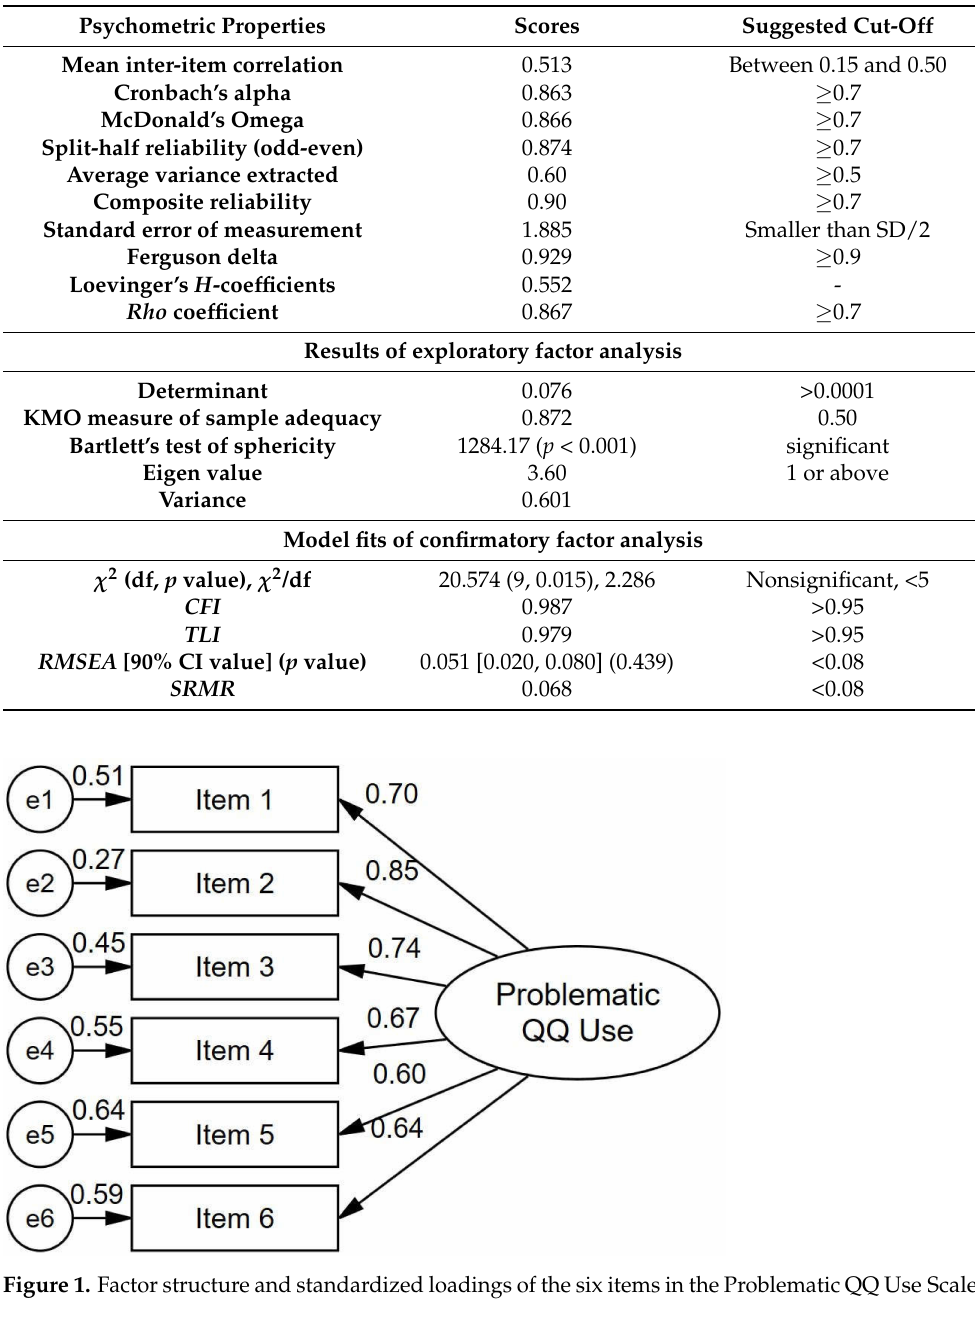
Table 3. Scale-level psychometric properties of the Problematic QQ Use Scale.